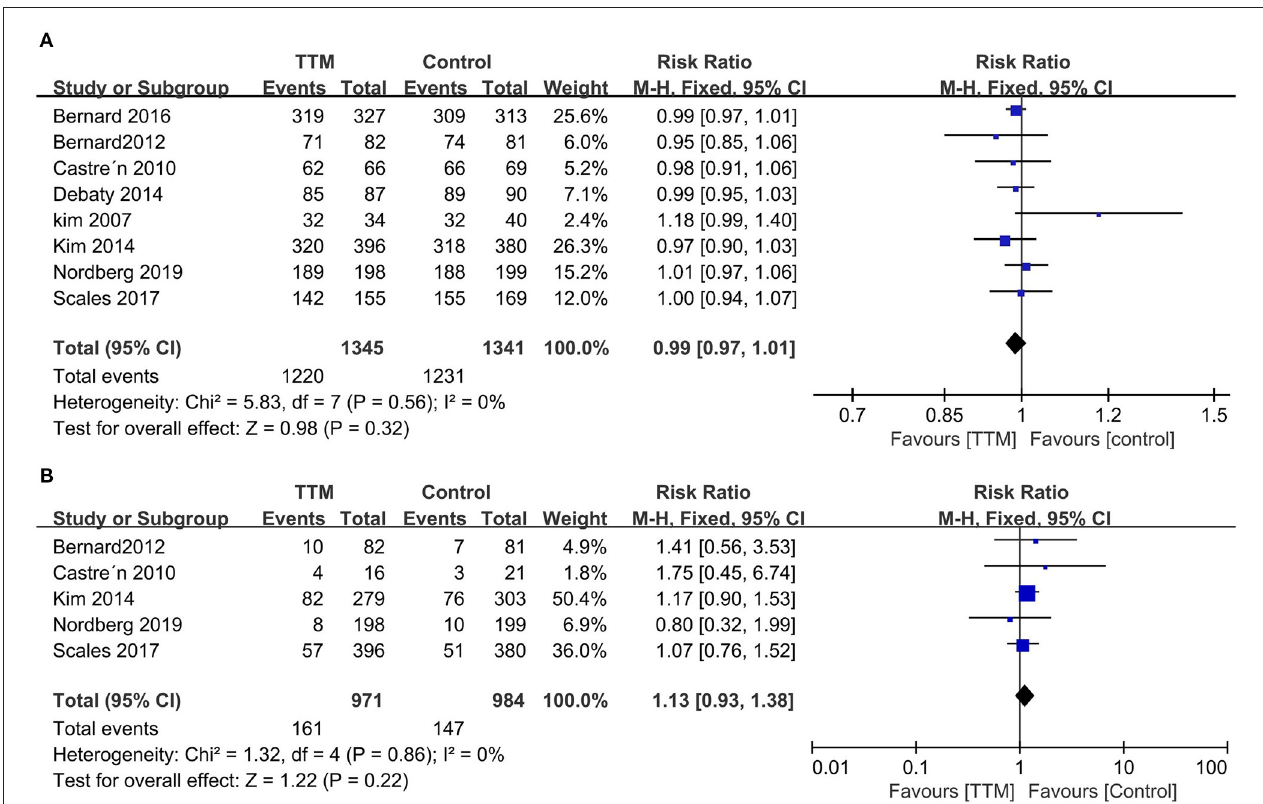
FIGURE 3 | Forest plot of the targeted temperature management used in pre-hospital or in-hospital survivors with non-shockable rhythm. (A) Mortality; (B) Good neurological